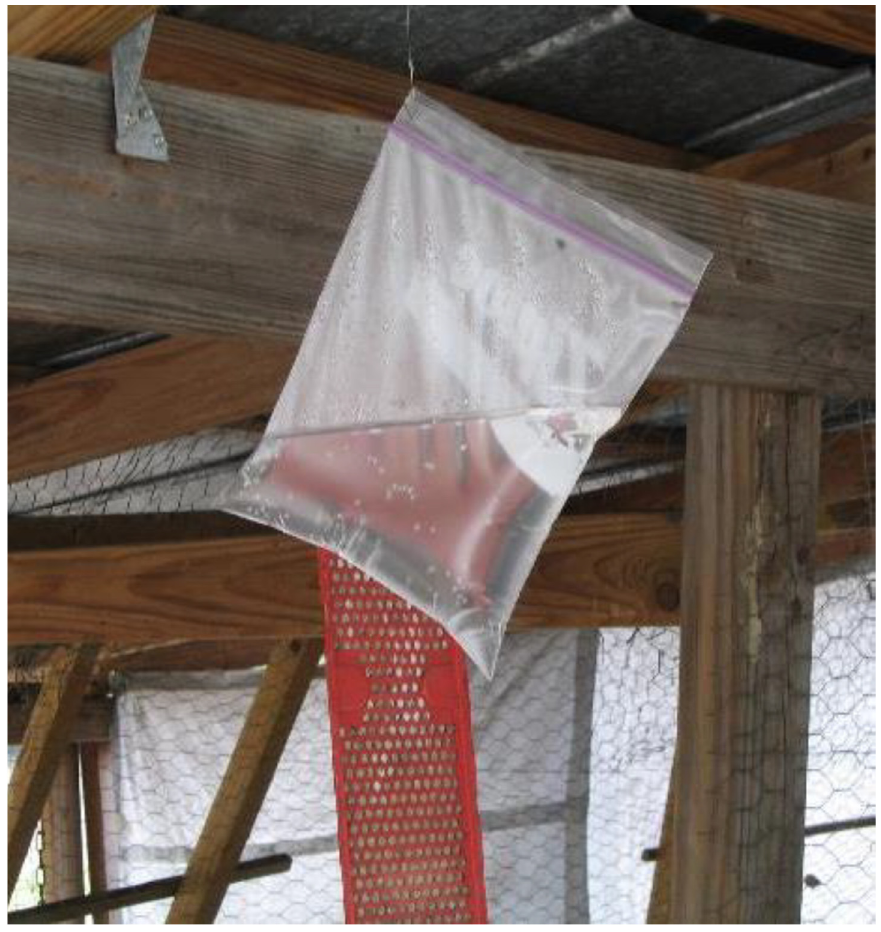
Figure 6. A bag of water without coins for fly management hanging in a pole shed near Newberry, Florida. A red QuikStrike Fly Abatement Strip can be seen hanging in the background.